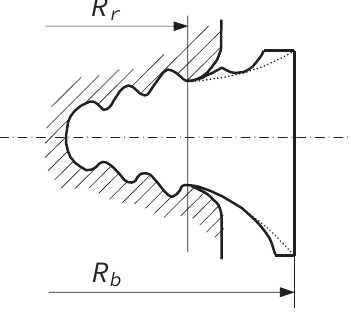
Fig. 3. Fir-tree root of the